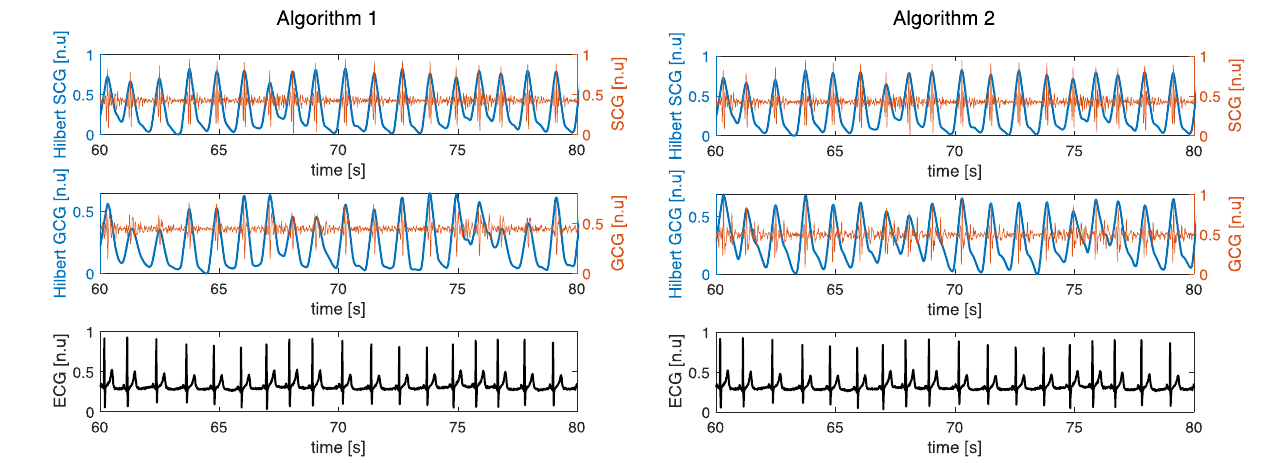
Figure 3. Example of 20 s of SCG and GCG signals (normalized between 0 and 1) obtained with algorithms 1 and 2 after the Hilbert filter application (blue lines) compared to raw SCG and GCG signals (orange lines) and reference ECG (black line, normalized between 0 and 1). In this specific case, Algorithm 2 selected the z -axis for SCG, while for GCG the same algorithm selected an axis different from y (default selection for Algorithm 1).